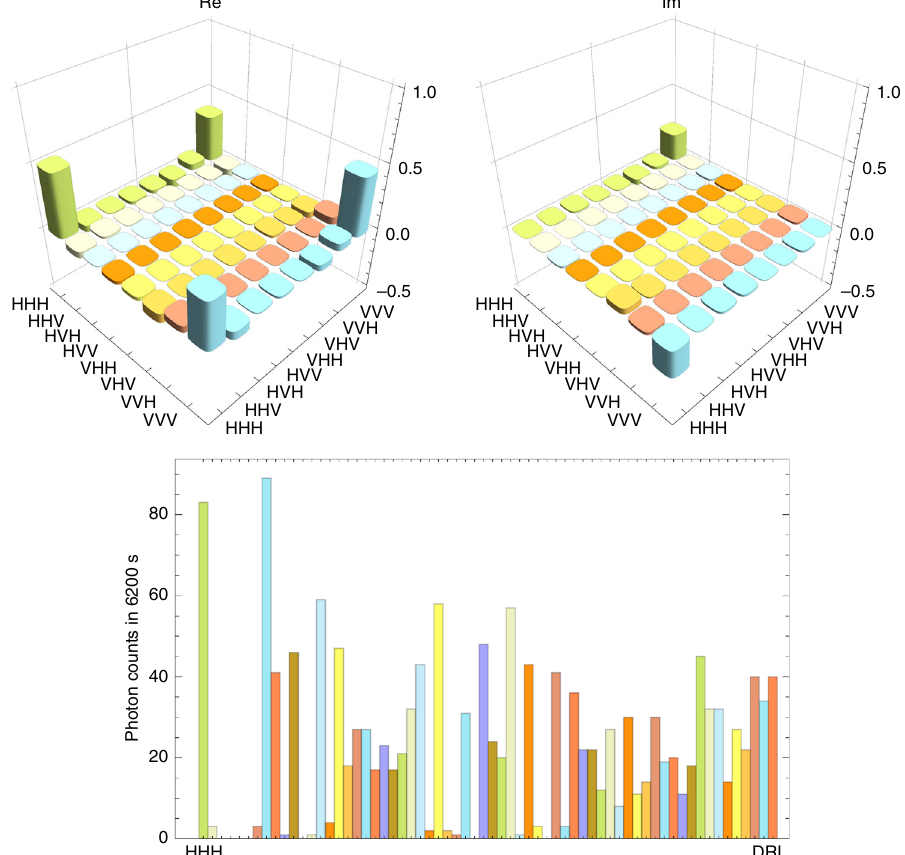
Fig. 4 Estimated quantum states expected to be a tripartite GHZ state. The upper graphs show the real and imaginary part of the reconstructed density matrix ρ c . The lower graph shows the measured coincidence counts in 64 basis states necessary for the reconstruction of the density matrix 5 c 2 c 1